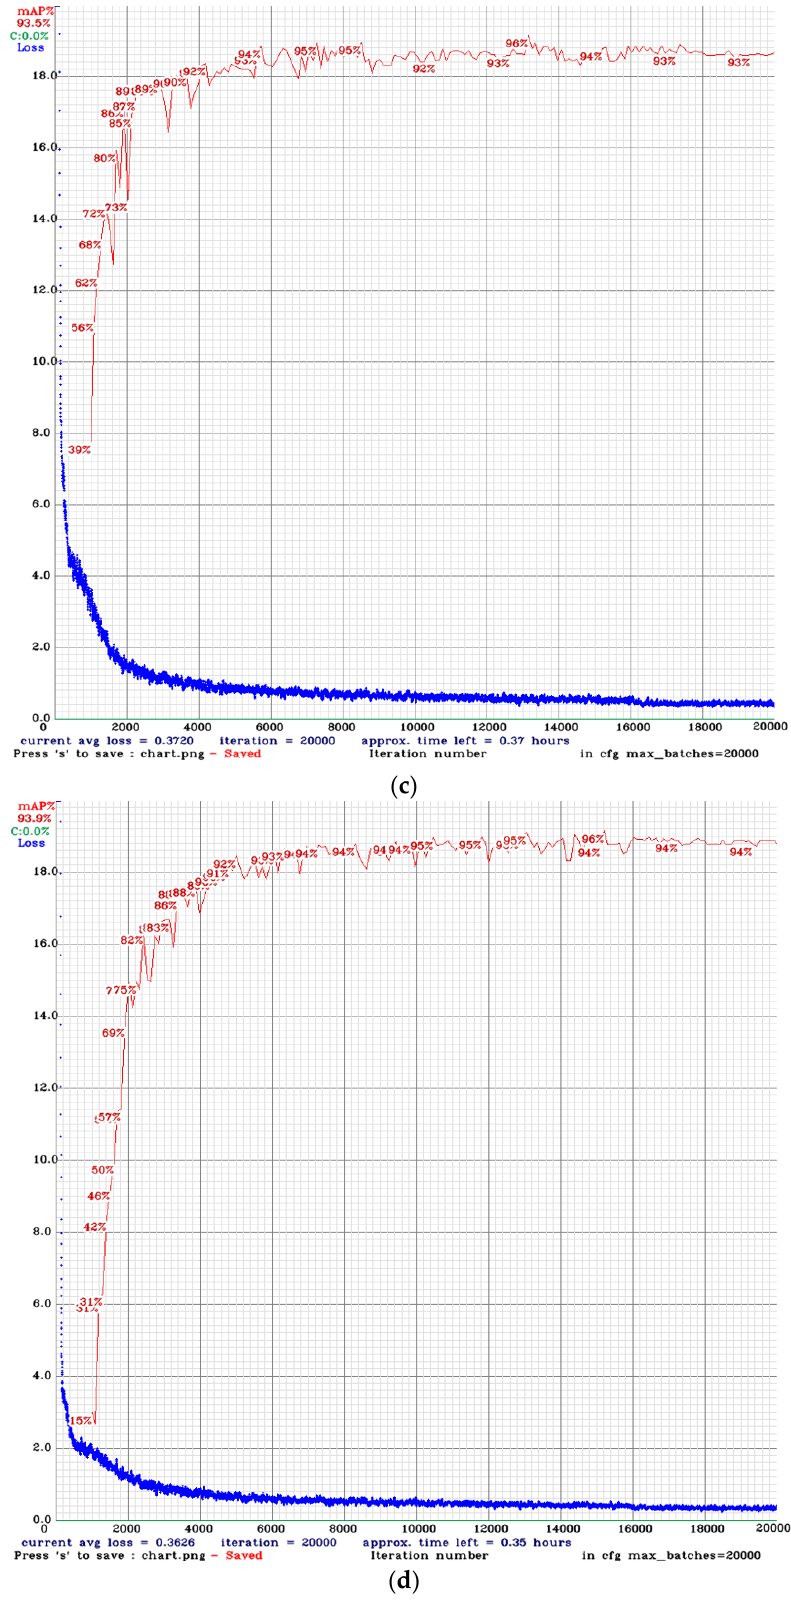
Figure 11. Graph of YOLOv4 trained with network size and IoU _threshold of ( a ) 416 × 416, 0.50 ( b ) 416 × 416, 0.75 ( c ) 608 × 608, 0.50 ( d ) 608 × 608, 0.75.